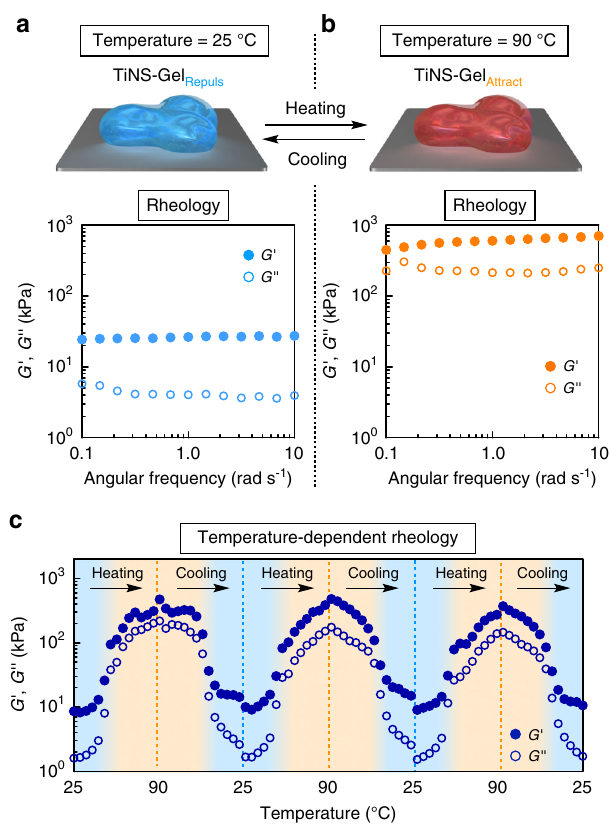
Fig. 4 Thermoresponsive switching of the mechanical properties of TiNS- Gel through the transition between TiNS-Gel Repuls and TiNS-Gel Attract . a , b Storage ( G ') and loss ( G '') moduli on frequency sweep (0.1 – 10 rad s − 1 ) at a fi xed strain (0.1%) of TiNS-Gel ([TiNS] = 14 wt%) with keeping the temperature at 25 °C ( a ) and 90 °C ( b ). c Changes in the G ' and G ″ values at a fi xed frequency (1 rad s − 1 ) and a strain (0.1%) of TiNS-Gel ([TiNS] = 14 wt%) upon repeated thermal scanning between 25 and 90